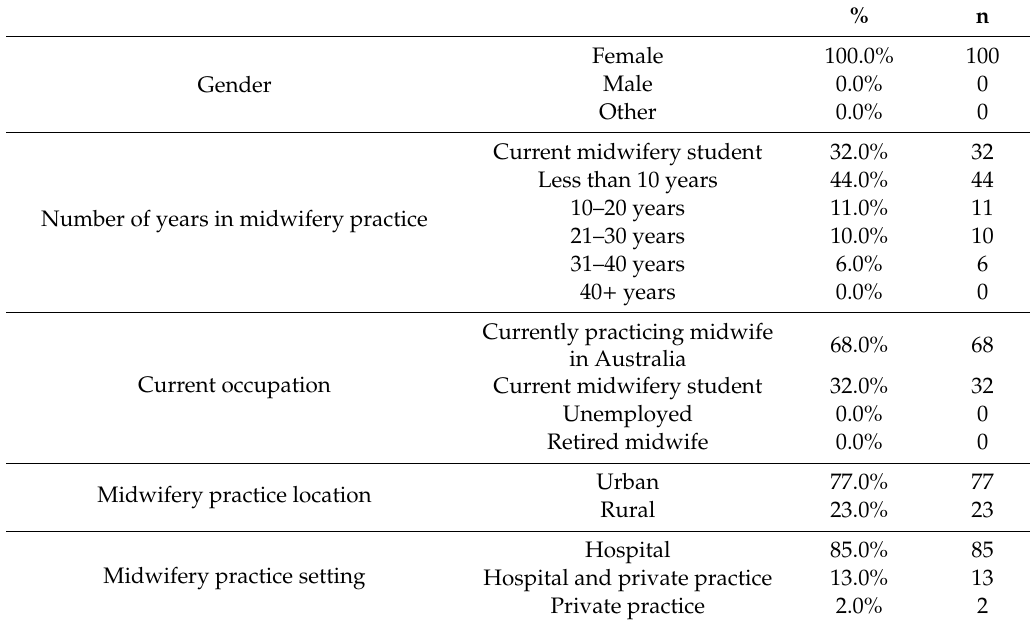
Table 1. Demographic characteristics and dental history of